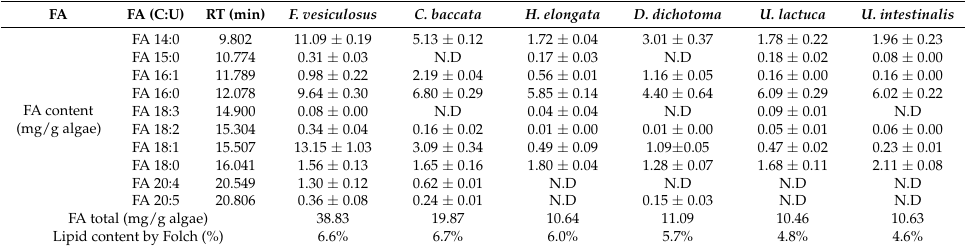
Table 2. Lipid content (%) and fatty acid composition (mg/g) of six algae species (dry weight). FA FA(C:U) RT(min)